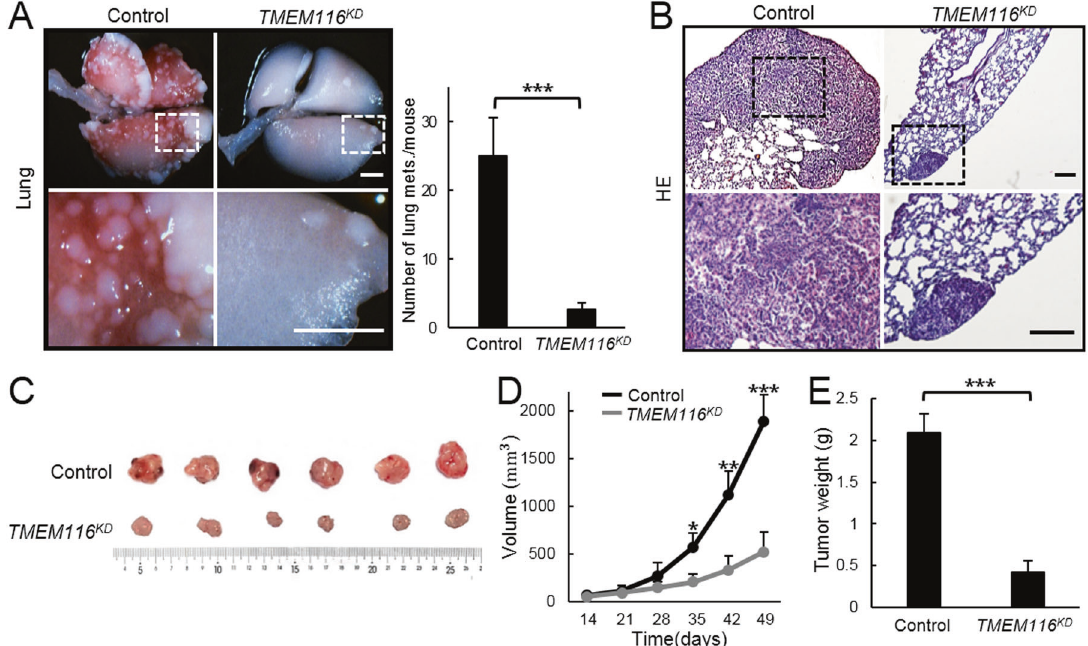
Fig. 4 TMEM116 de fi ciency suppresses tumor growth and metastasis in vivo. A After tail vein injection by TMEM116 KD or control cells, metastatic nodules on lung surface were analyzed. Scale bar: 2 mm. B The xenografts tumorigenesis were analyzed by H&E staining. Scale bar: 200 μ m. After subcutaneous injection into the fl anks, tumor size ( C ), tumor volume ( D ), and tumor weight ( E ) were measured and analyzed. * P < 0.05, ** P < 0.01, *** P < 0.001. Representative images from three independent experiments are shown Fig. 5, alterations of PDK1, p-AKT, p-FOXO3A, p63, and E-cadherin caused by TMEM116 de fi ciency were corrected by PS48 treatment